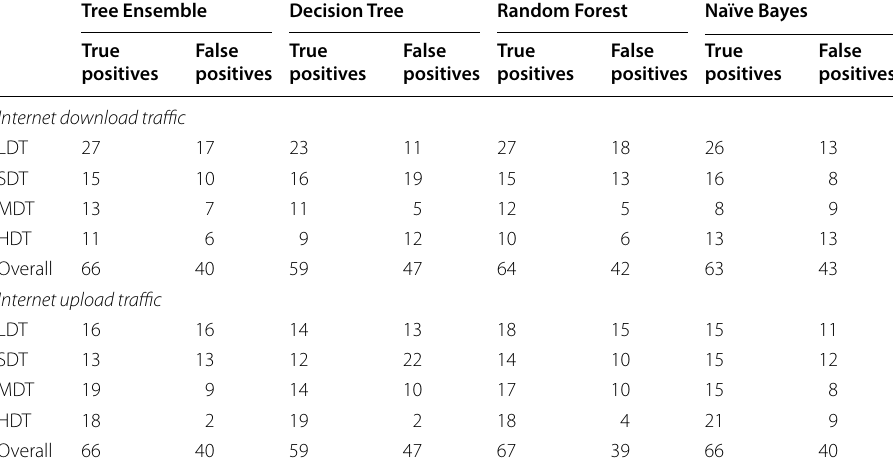
Table 13 The confusion analysis for the four machine learning algorithms on KNIME